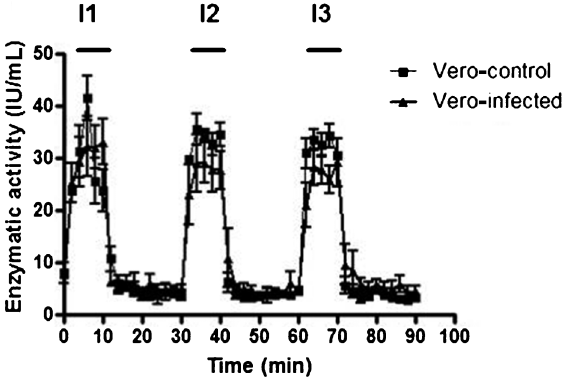
Figure 1. Average evolution of enzymatic activity (AST) in ischemia-reperfusion cycles. The graph shows the values of enzymatic activity measured every 2 min during the three ischemia-reperfusion cycles. Thick horizontal lines (top) indicate the different ischemia stages and are identified as I1 (ischemia 1), I2 (ischemia 2), and I3 (ischemia 3) and match the increased AST activity. The graph averages the data of Vero-control (n = 12) and Vero-infected hearts (n = 14).